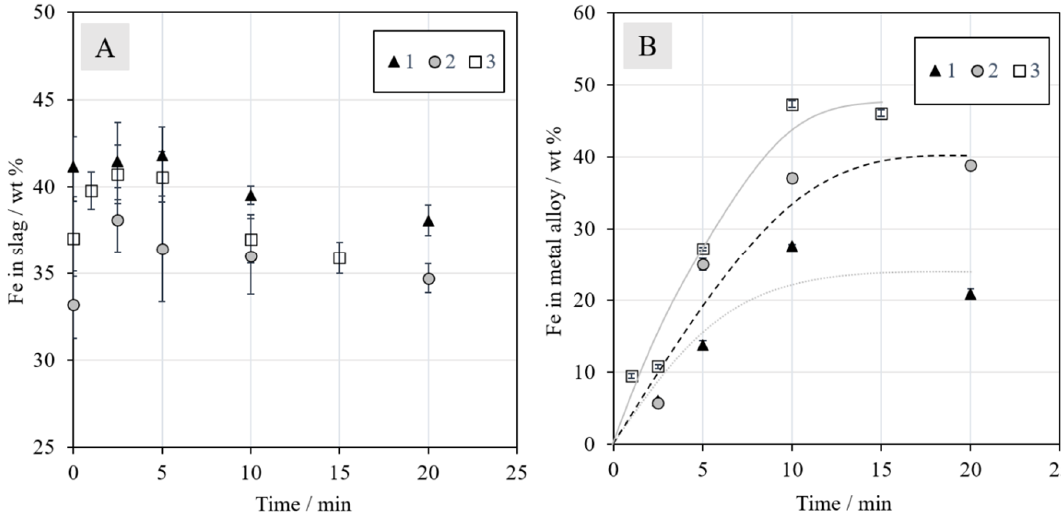
Figure 7. Concentrations (wt %) of iron in ( A ) slag and ( B ) metal alloy during reduction with N 2 + 5% CH 4 .